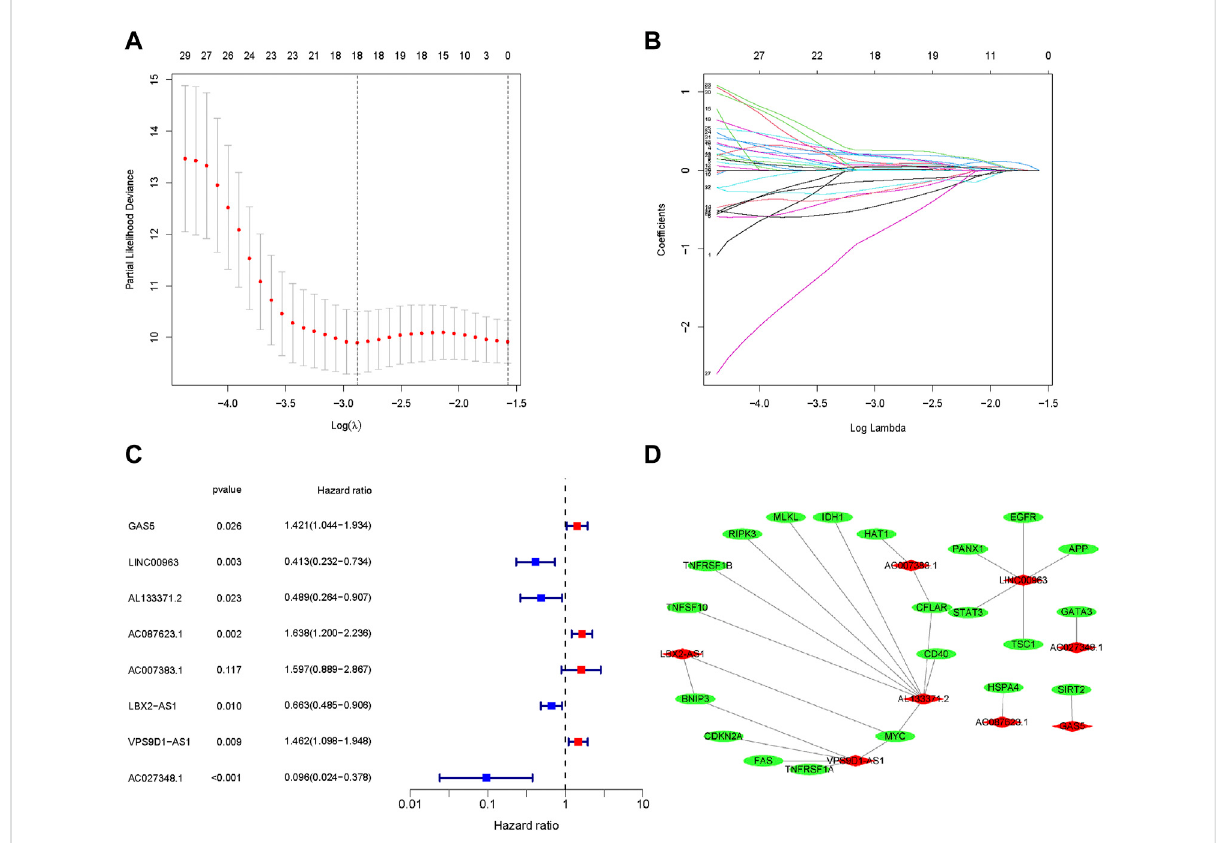
FIGURE 3 Construction of a prognosticpyroptosis-associated lncRNA signature. (A,B) . The LASSO Cox analysis determined 15 prognosticgenes. (C) . The forest map of multivariate Cox analysis. (D) . The network between lncRNAs and necroptosis genes (correlation coef fi cients > 0.3 and p <